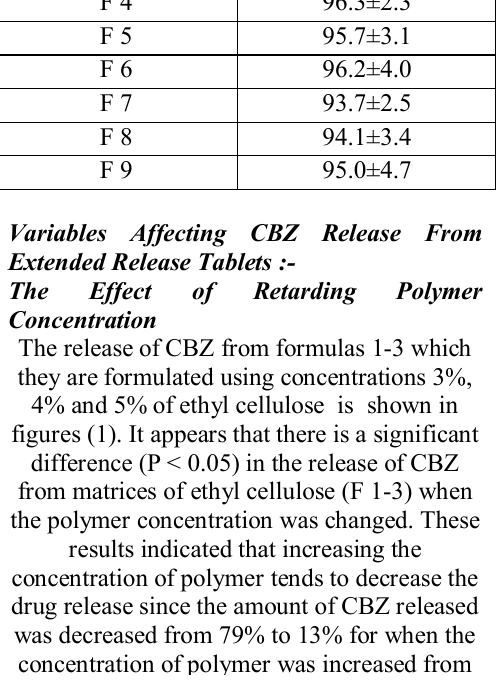
Table 3: Friability of Tablets.